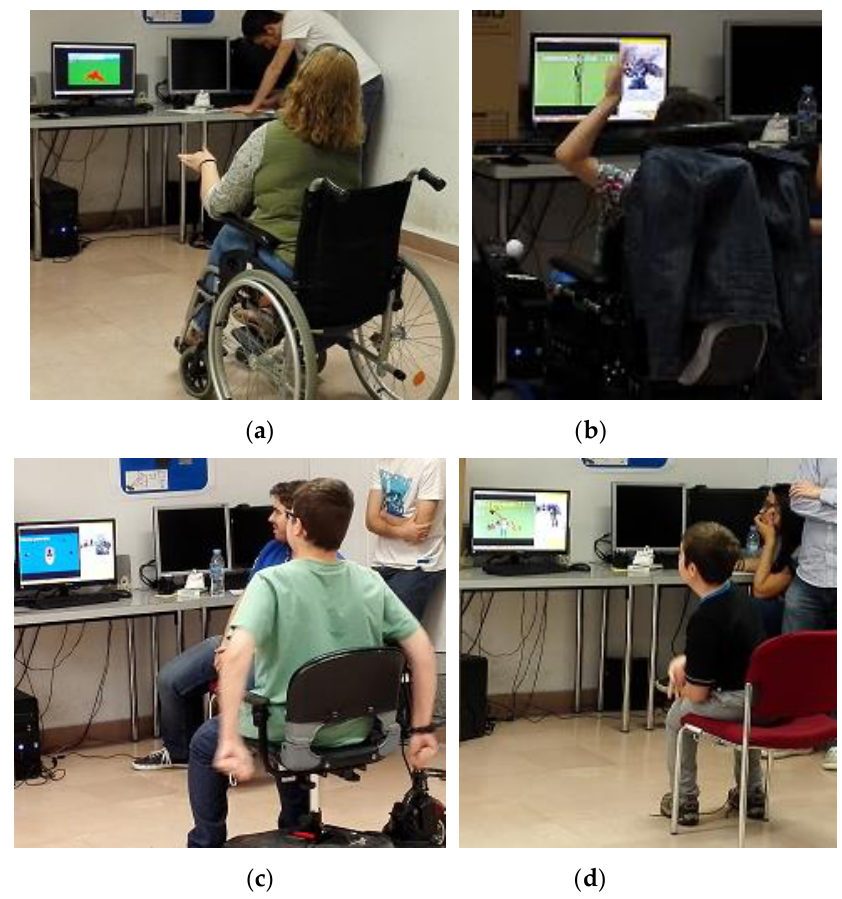
Figure 8. Different scenes while the volunteers were playing. ( a ) “The Paper-Bird”, ( b ) “The Ladder”, ( c ) “The Boat” and ( d ) “Whack-a-Mole”.